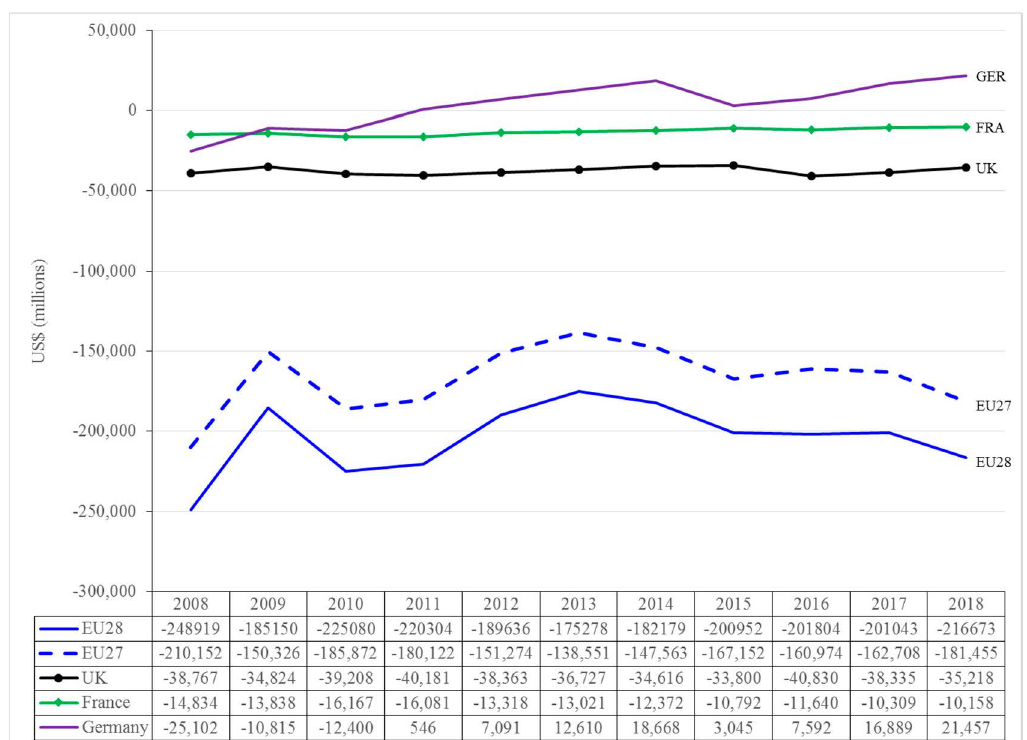
Trade balance with China (US$ [millions]), 2008–18. Source: International Monetary Fund, ‘Direction of Trade Statistics’ (2020) <http://data.imf.org/?sk=9D6028D4-F14A-464C-A2F2-59B2CD424B85>